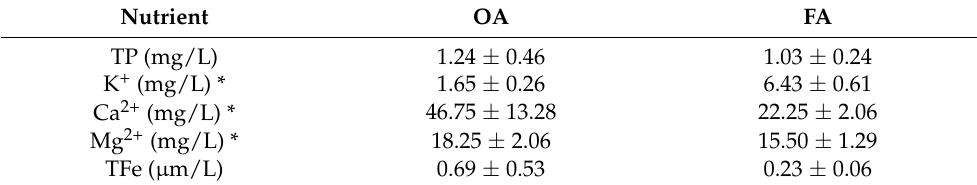
Table 2. Effect of wave exposure and macroalgal age on the macro- and micronutrient content. Values presented in the table are means across replicates of each algal sample ( n = 4) with standard deviation (SD). OA: old algae (decaying macroalgae debris), FA: fresh algae (living macroalgae). Nutrient OA FA TP (mg/L) 1.24 ± 0.46 1.03 ± 0.24 K + (mg/L)